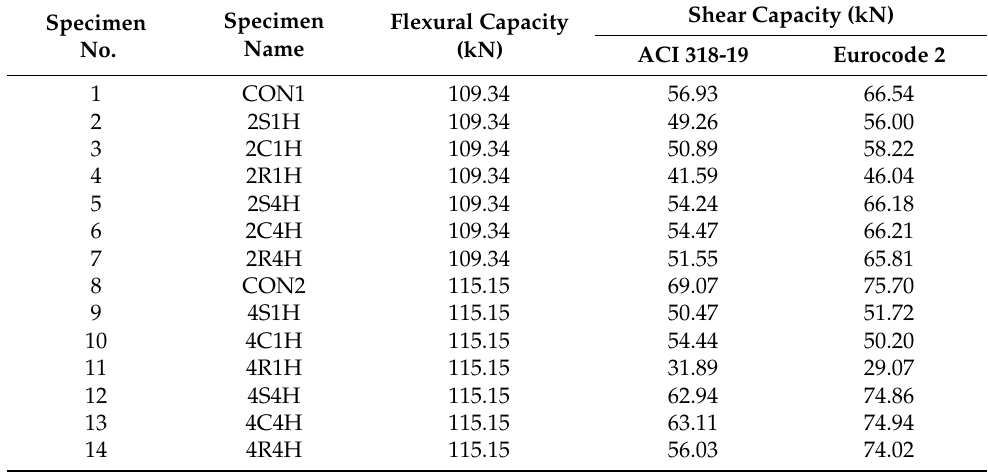
Table 2. Nominal flexural and punching shear capacities of tested